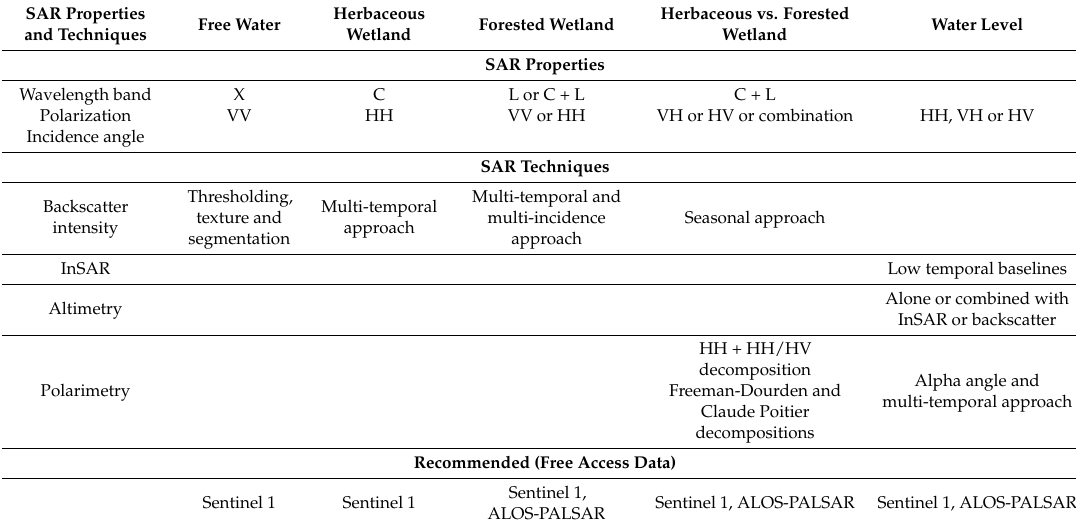
Table 3. Recommendations for the use of SAR properties and techniques in order to characterize wetlands